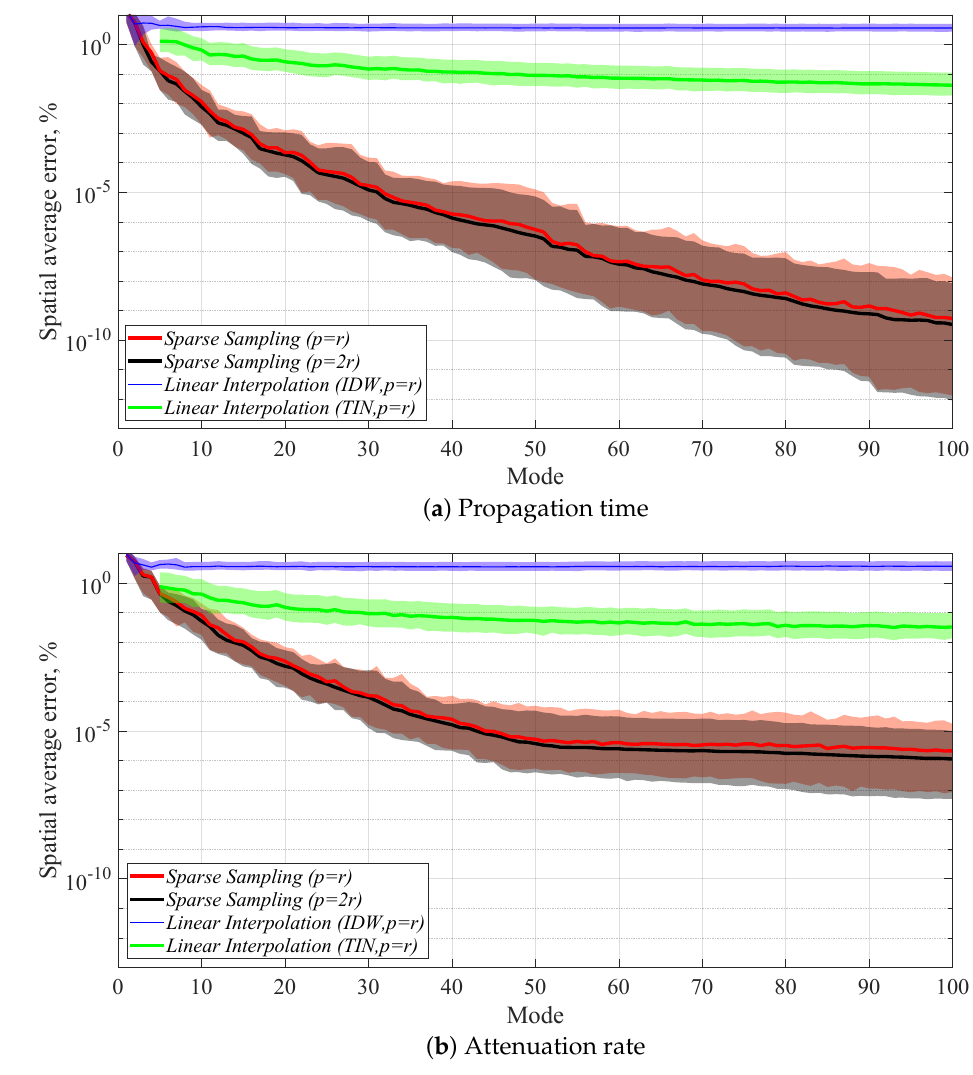
Figure 7. Spatial average of relative error for each number of modes. Here, shaded region shows the range from the minimum to maximum values obtained for 50 runs with different random